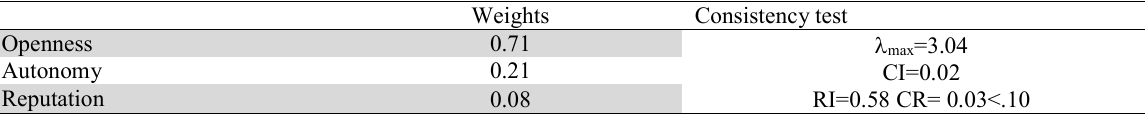
Analysis of the sub-factors of “MOOCs features”